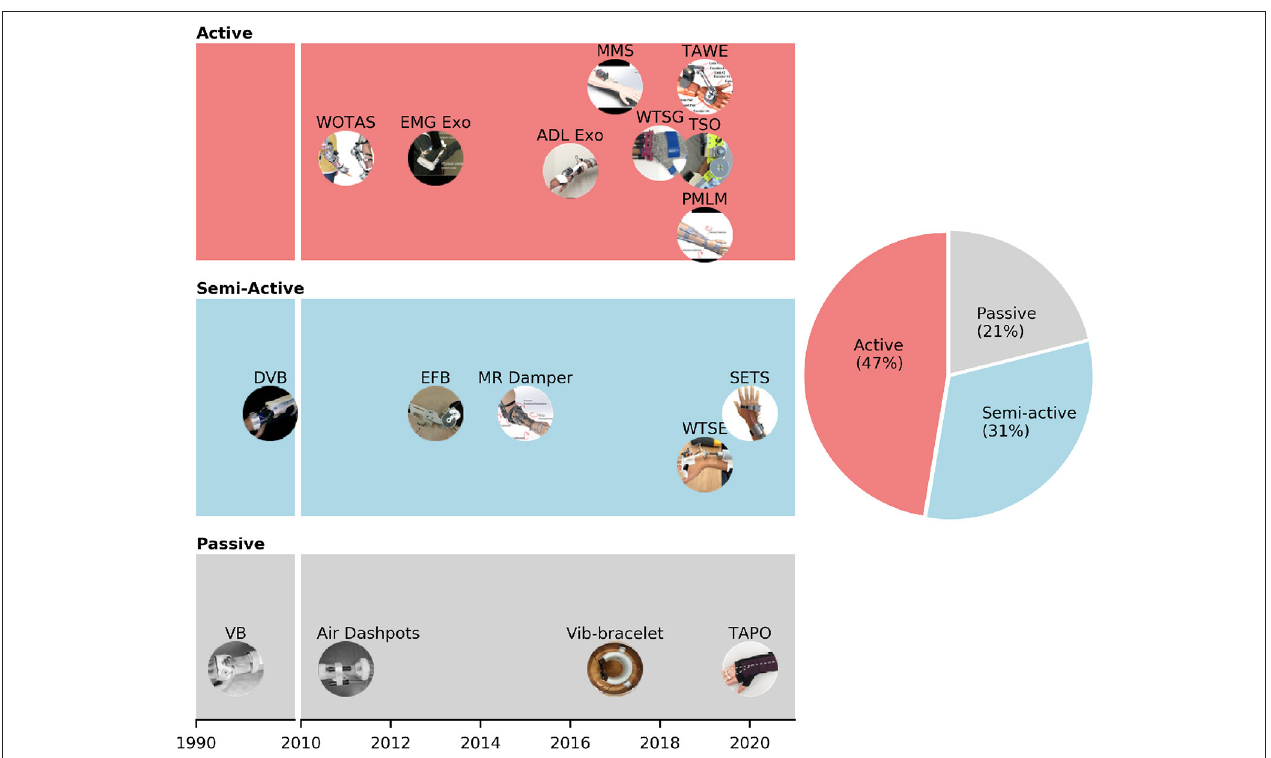
FIGURE 3 | Different suppression mechanisms (passive, semi-active, and passive) of wearable orthoses for tremor suppression.